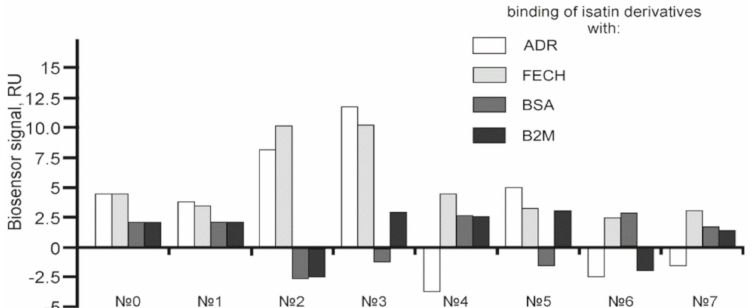
Figure 3. The average values of binding levels of isatin derivatives (100 µ M) with immobilized on the CM5 optical chip FECH monomer form, ADR, B2M and BSA ( n = 3). FECH, ADR and control proteins B2M and BSA were immobilized up to 4000 ± 200 RU levels using the standard amino-coupling protocol. Isatin and its derivatives were dissolved in 96% ethanol. Isatin derivatives samples in HBS-EP + bu ff er containing 1% v / v ethanol were injected for 10 min at a flow rate of 10 µ L / min. A solution containing 2M NaCl and 0.4% CHAPS was used for chip surface regeneration for 30 s at a flow rate of 25 µ L / min.